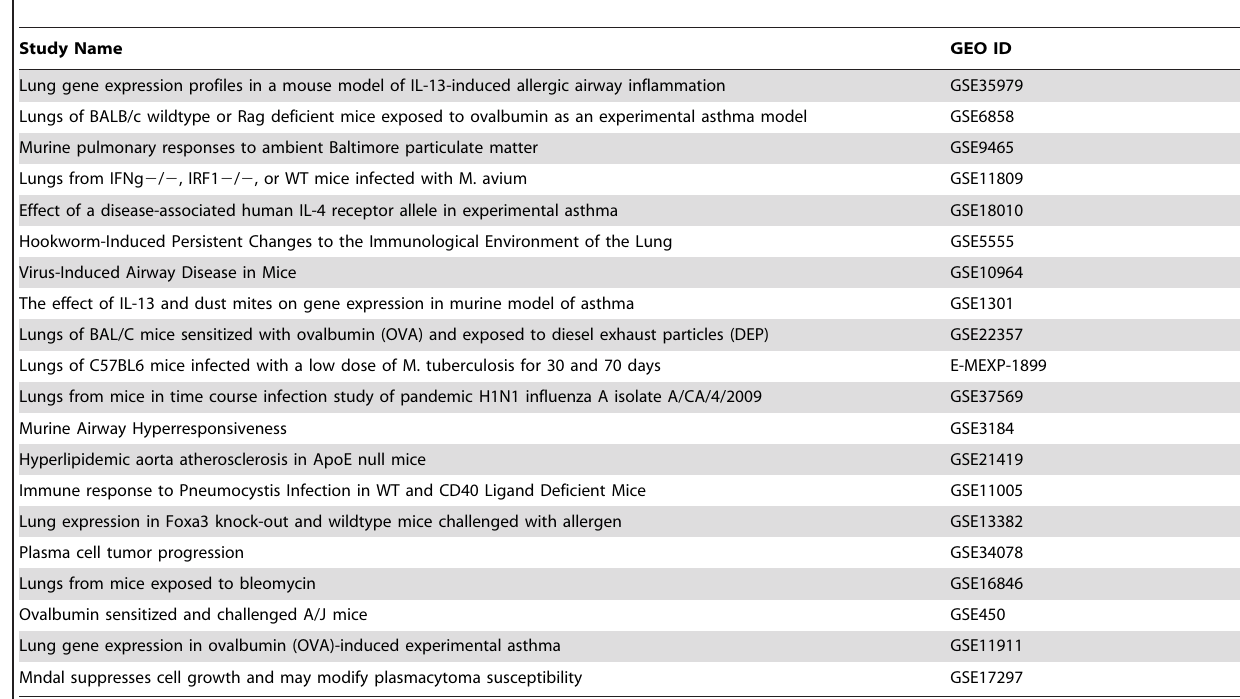
Table 3. Identifying other studies with similar expression of 101 gene signature in the context of the public corpus of gene expression studies using NextBio.